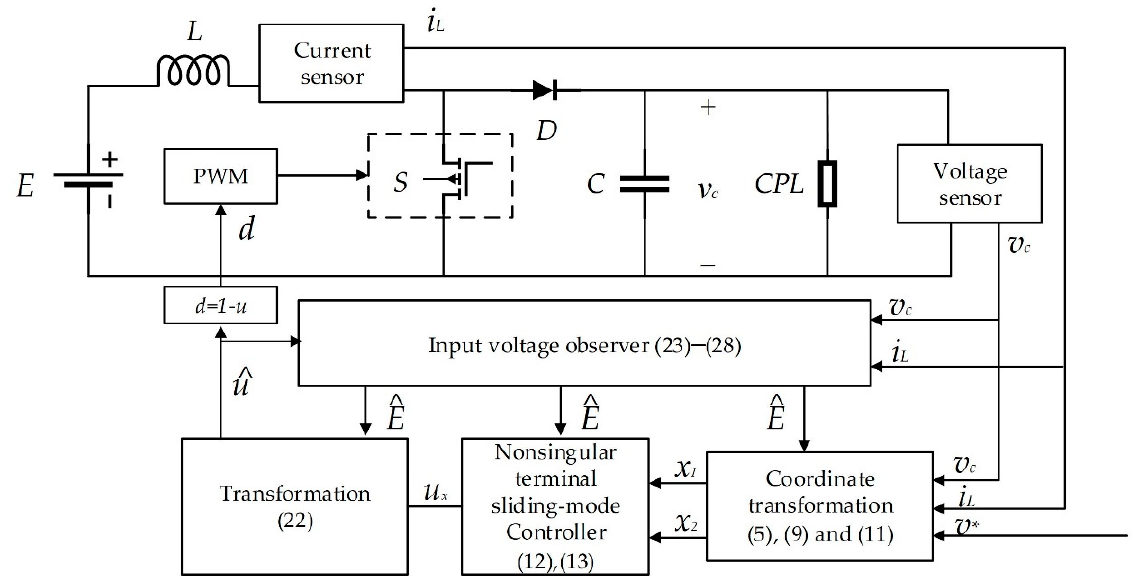
Figure 3. The simulation schematic of the proposed controller. Table 1. The parameters of boost converter with CPL. Parameters Symbols Values